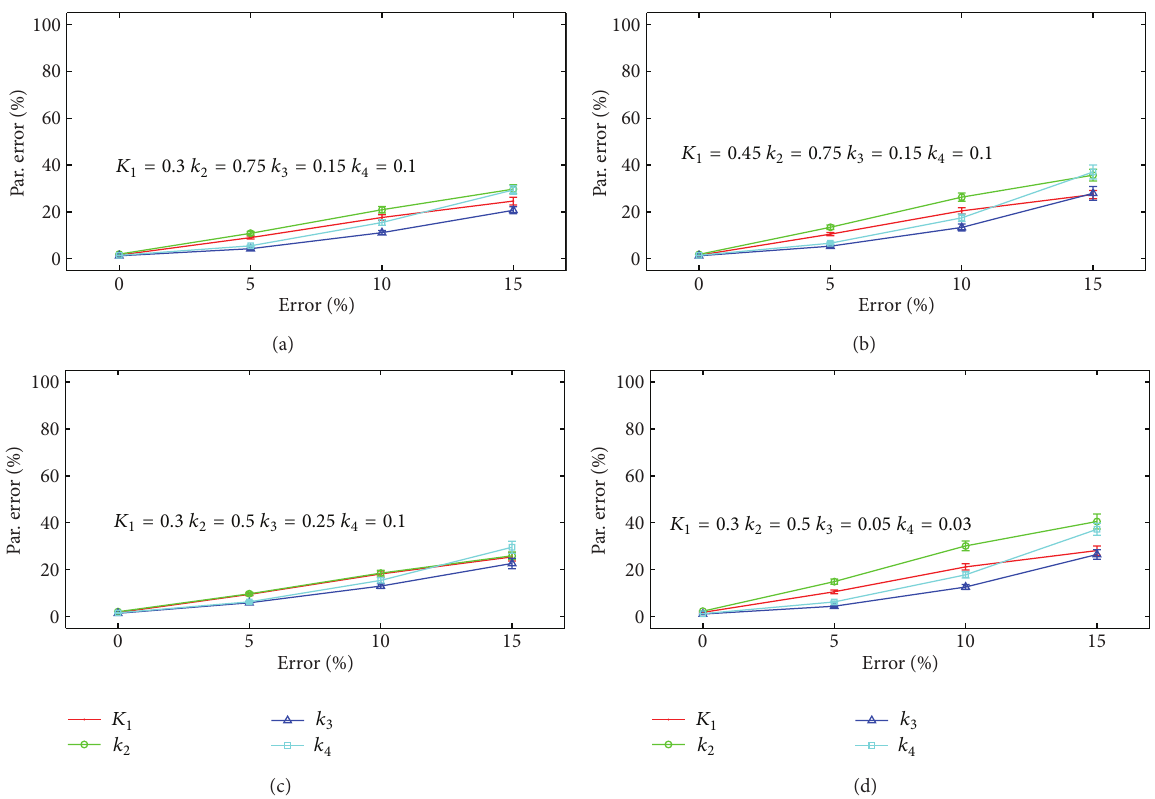
Figure 6: The error in the estimated PET kinetic parameters as a function of the error in the DCE-MRI parameters. Each panel corresponds to a different set of PET kinetic parameters. For each parameter combination, the error in the PET parameters is below 25% provided the error in the DCE-MRI parameters is below 10%. As the DCE-MRI parameter error increases, the error in the PET parameters exceeds 40% in some cases (see panel